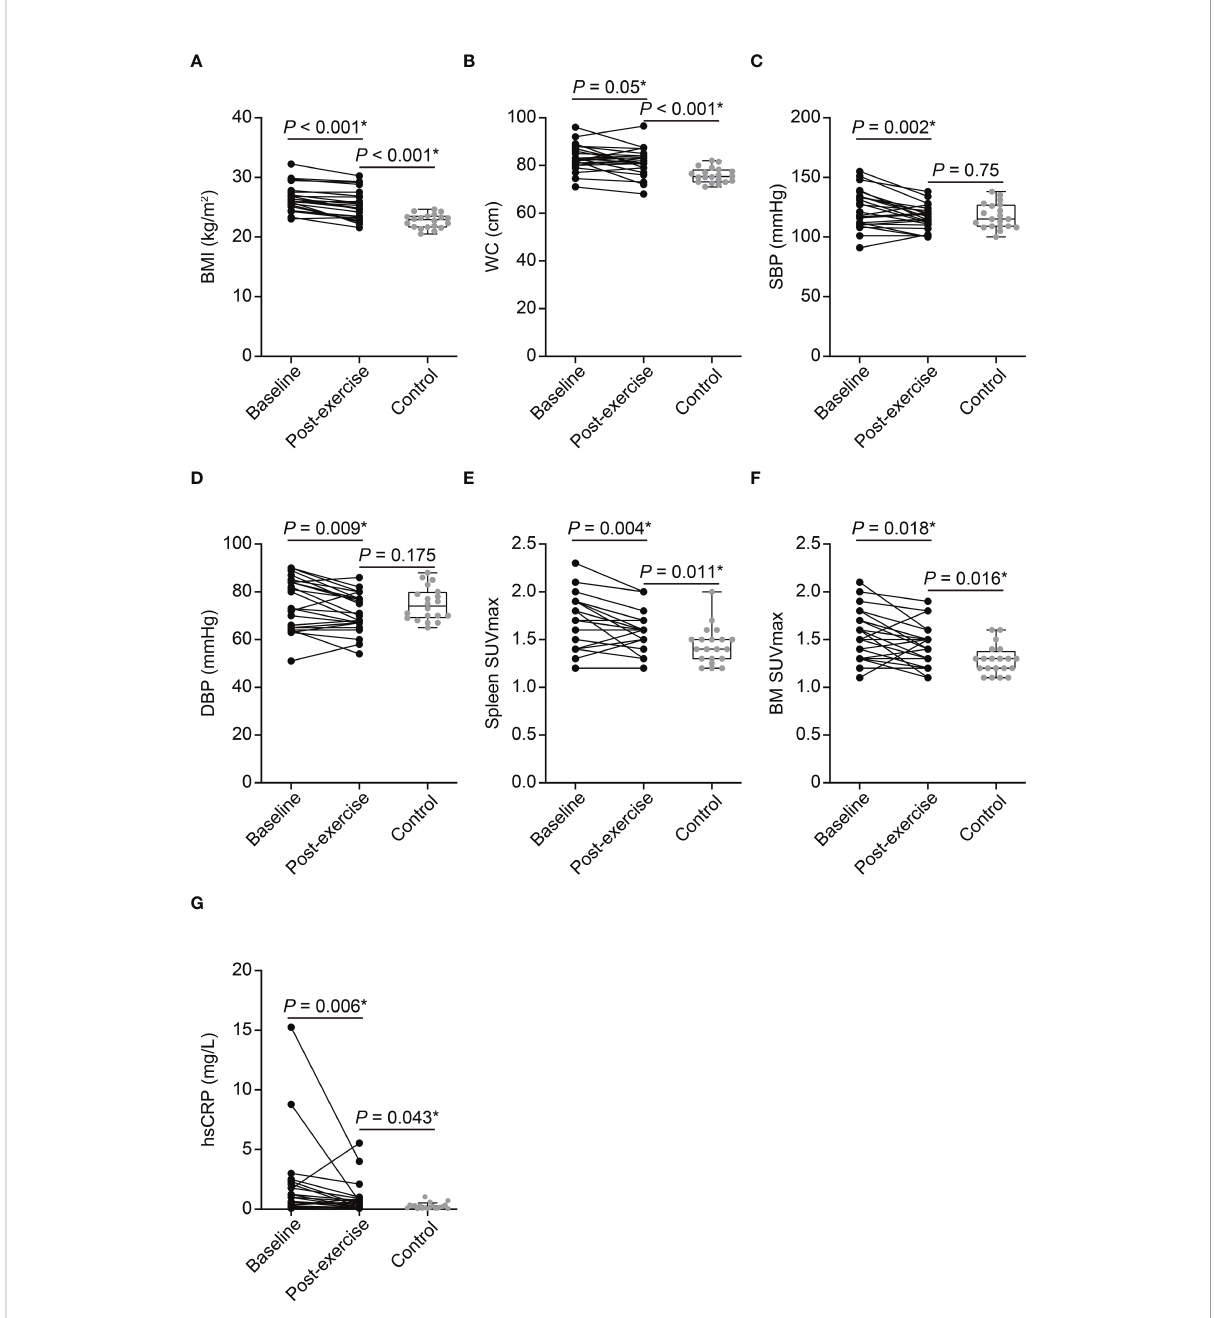
FIGURE 2 The effect of exercise on clinical parameters of obese women and comparison between post-exercise obese women and control participants (A – G) . BMI, body mass index; WC, waist circumference; SBP, systolic blood pressure; DBP, diastolic blood pressure; SUVmax, maximum standardized uptake value; BM, bone marrow; hsCRP, high-sensitivity C-reactive protein. P -values of BMI, WC, SBP, DBP, spleen SUVmax, BM SUVmax, and hsCRP between baseline and post-exercise obese women were determined using paired t -test. P -values of BMI, WC, SBP, DBP, spleen SUVmax, and BM SUVmax between post-exercise obese women and control group were determined using Student ’ s t -test. P -value of hsCRP between post-exercise obese women and control group was determined using Mann – Whitney U test. *Statistically signi fi cant